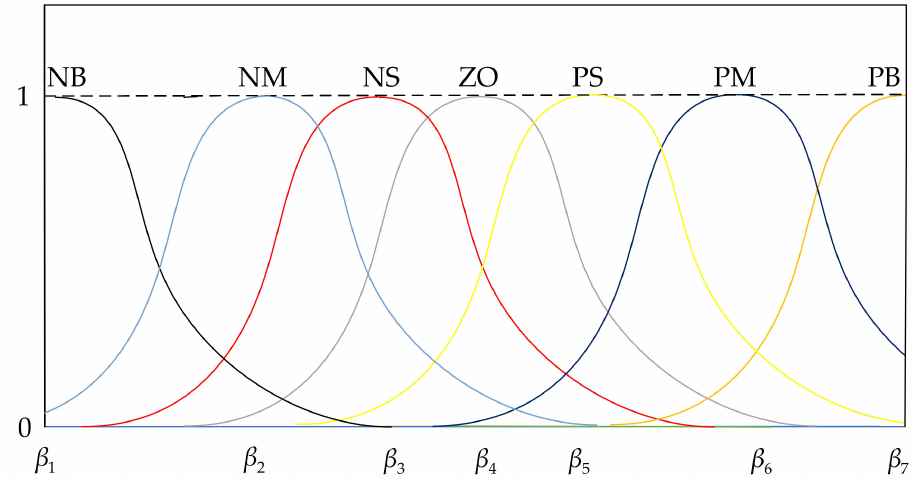
Figure 5. Membership function for the derivative of position